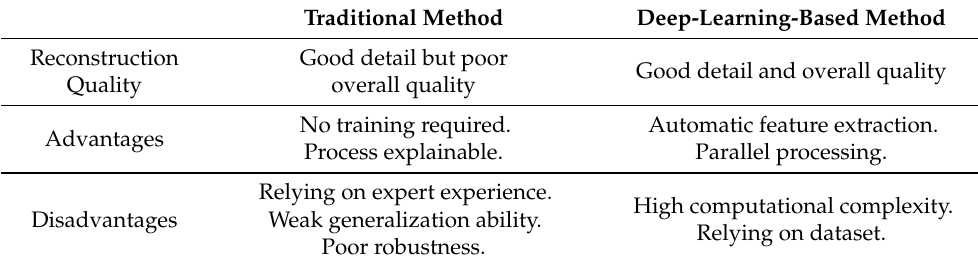
Table 3. Comparison of traditional methods and deep-learning-based methods for light field image super